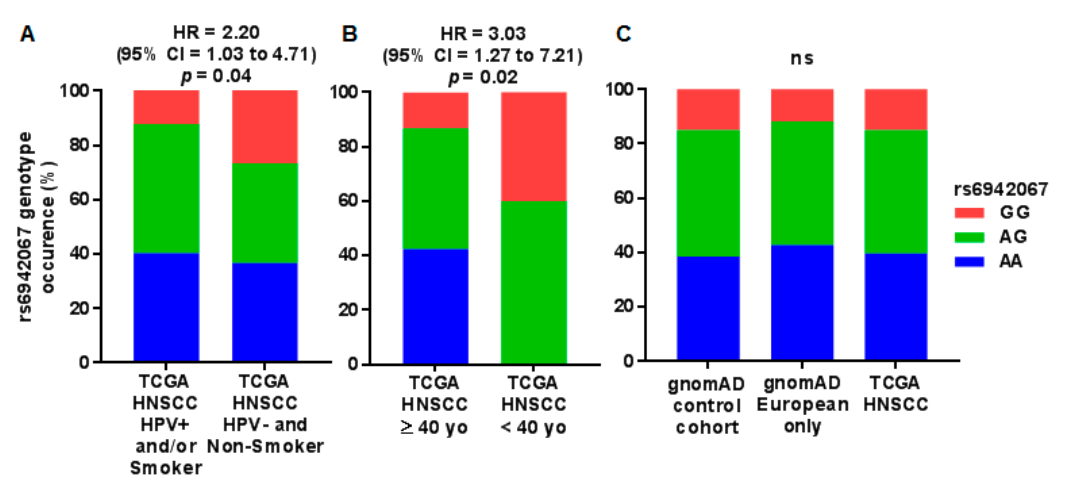
status, HPV status, tumor size, and nodal status. p values were calculated by a two-sided Pearson’s chi-square test and corrected for false discovery rate (FDR) using the Benjamini–Hochberg procedure. The absence of independent significance for HPV and smoking status suggests that it is the complete absence of HNSCC risk factor which is associated with the rs6942067 GG genotype. Table 1. Clinical features of the TCGA HNSCC cohort stratified by rs6942067 status.